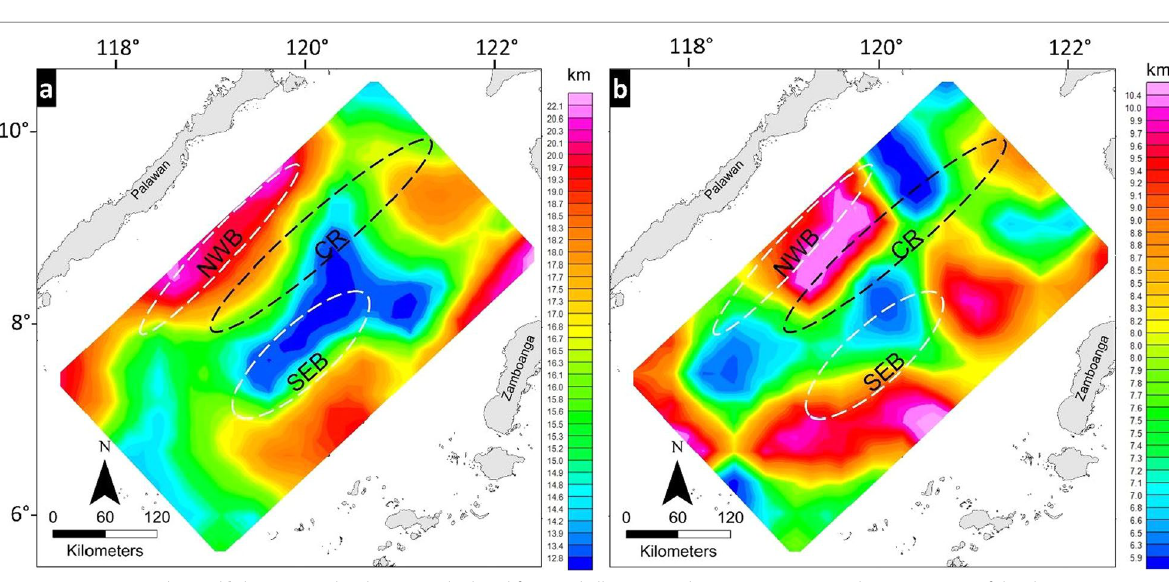
Fig. 9 Average a Moho and b basement depth maps calculated from radially averaged power spectrum technique. Traces of the three major features: NWB Northwest Basin, CR Cagayan Ridge, SEB Southeast Basin are overlaid on the maps = = =